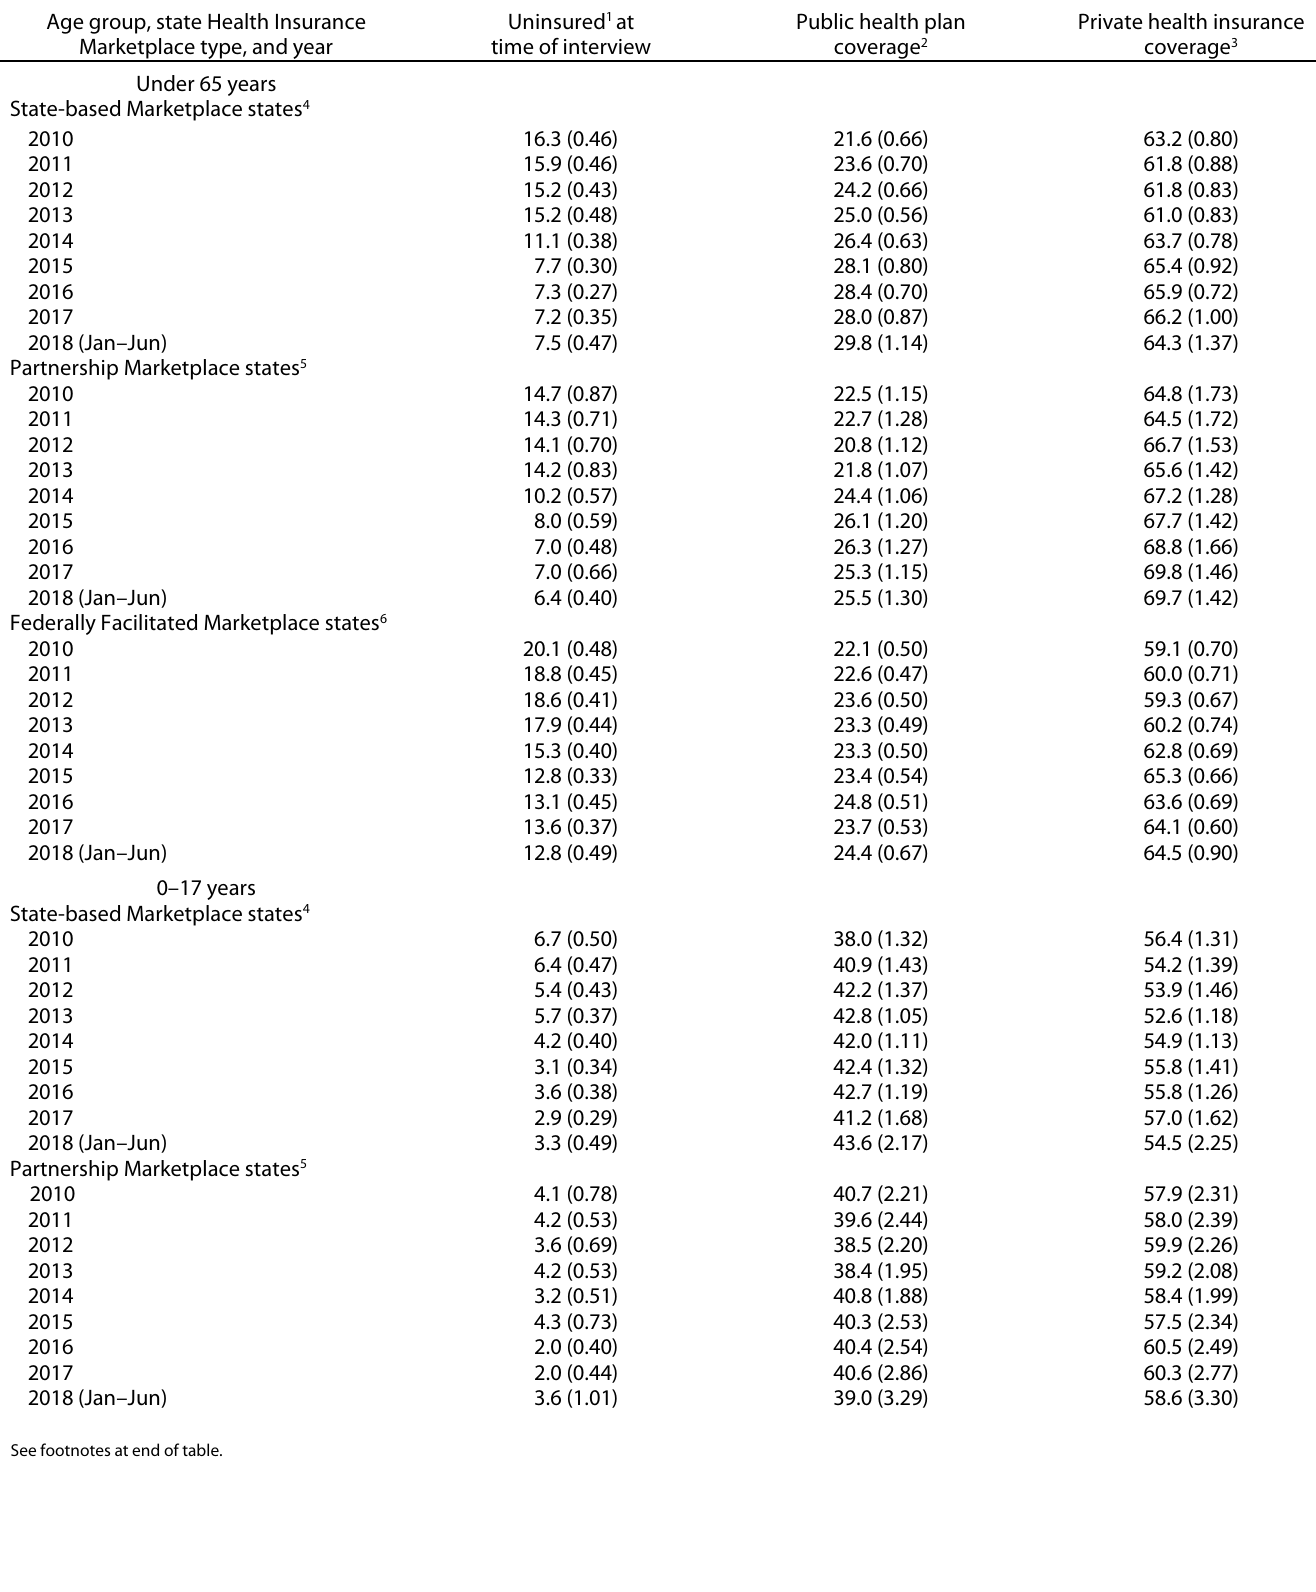
Table XIV. Percentages (and standard errors) of persons under age 65 who lacked health insurance coverage, had public health